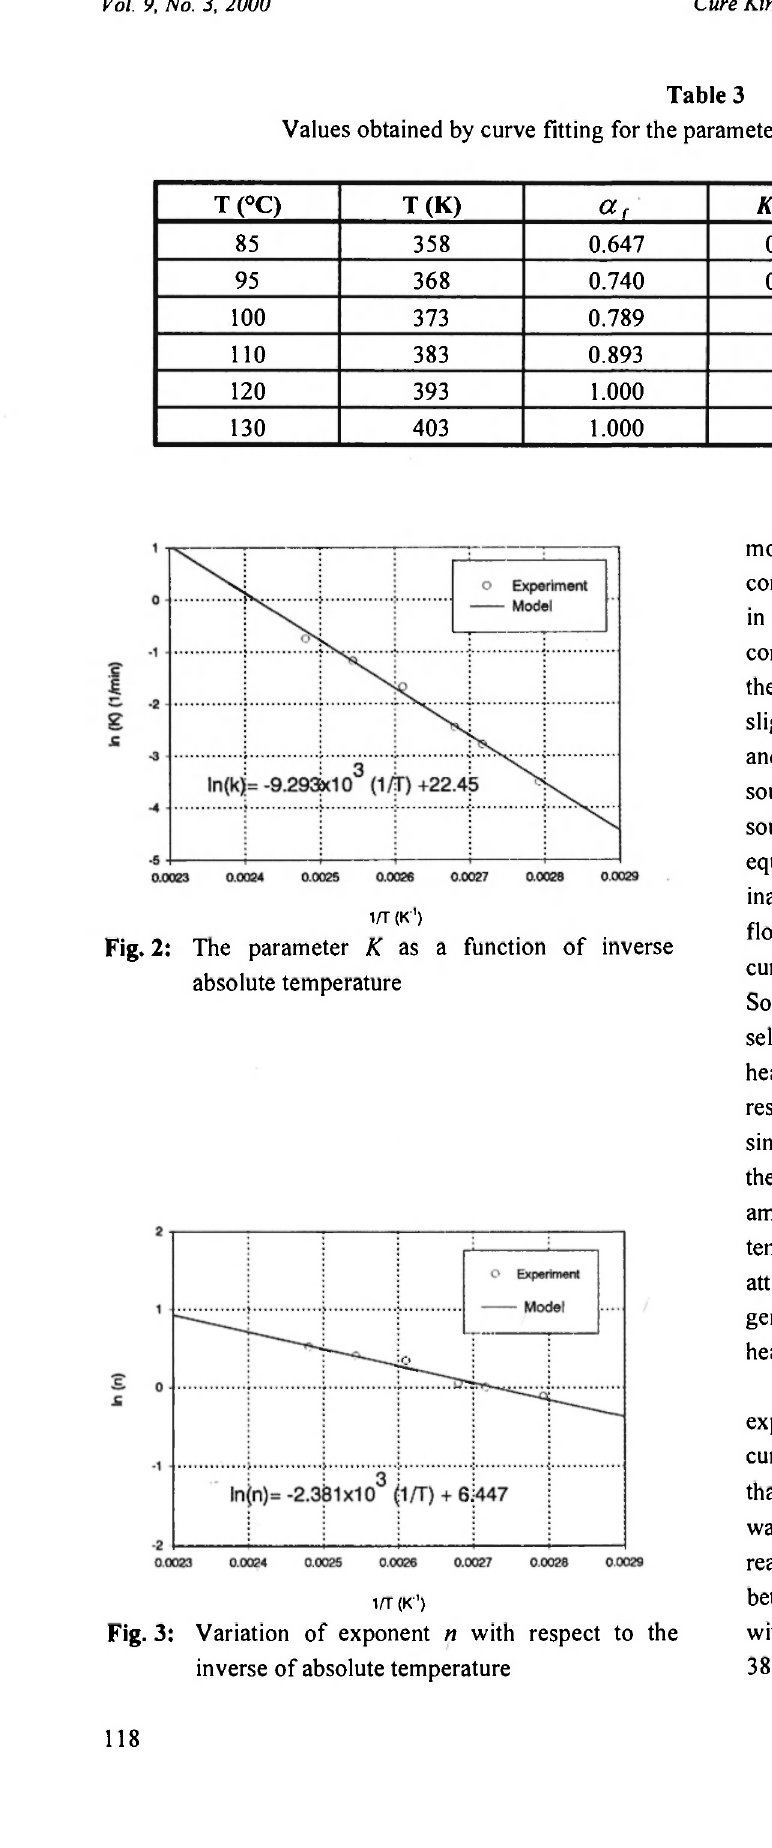
Values obtained by curve fitting for the parameters Κ and η at different temperatures.